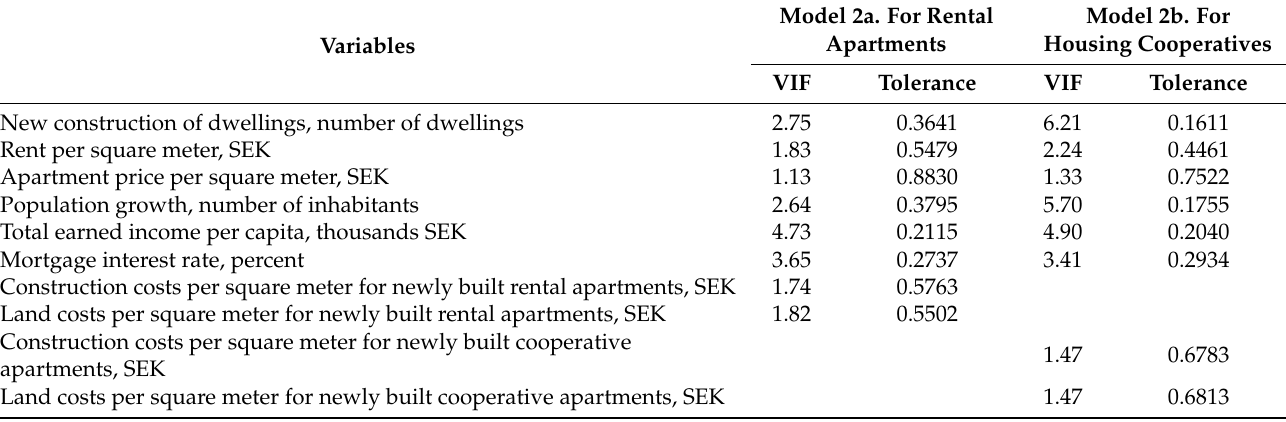
Table A5. Results of the VIF tests on variables in models 2a and 2b.